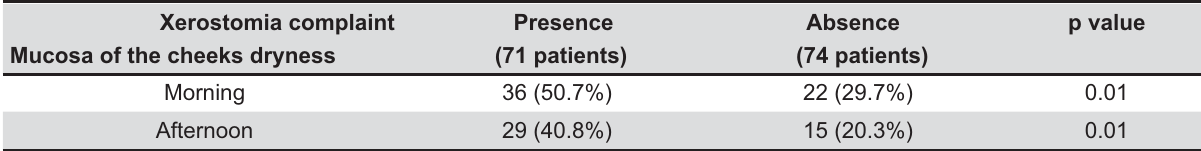
Table 2- Relation between xerostomia complaint and total number of patients with mucosa of the cheeks dryness in the morning and in the afternoon